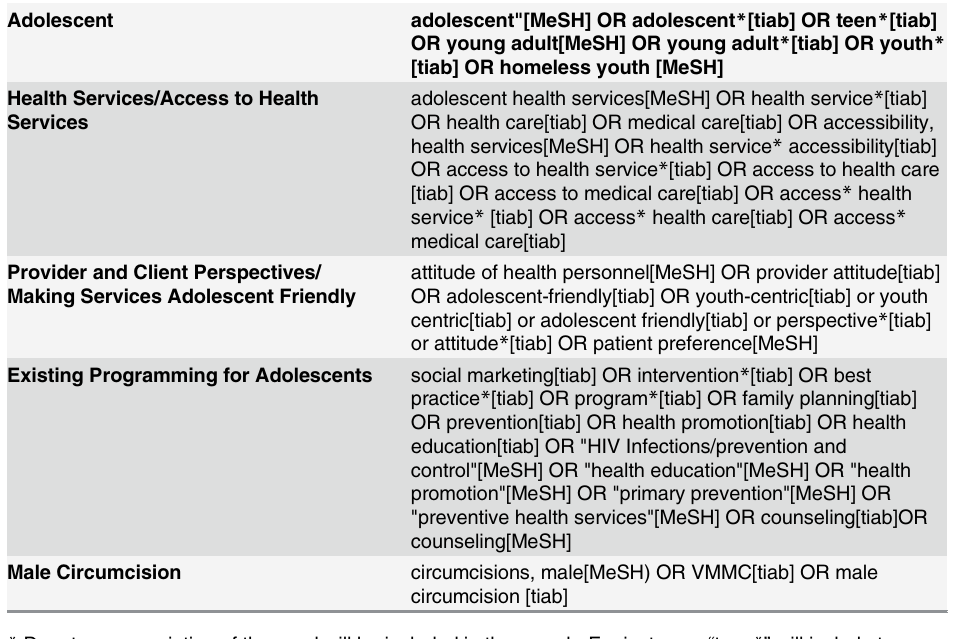
Table 1. Key Search Terms for PubMed